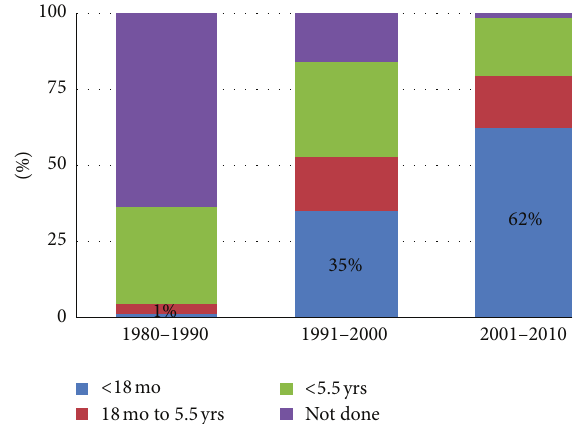
Figure 2: Percentage of performed MRI scans by time from disease onset among MS cases diagnosed between 1981 and 2010. Table 1: Characteristics of MS cases in Pirkanmaa, Sein¨ajoki, and Vaasa during the period 1981–2010. Figure 3: F/M-ratio by total number in 10-year-age groups among